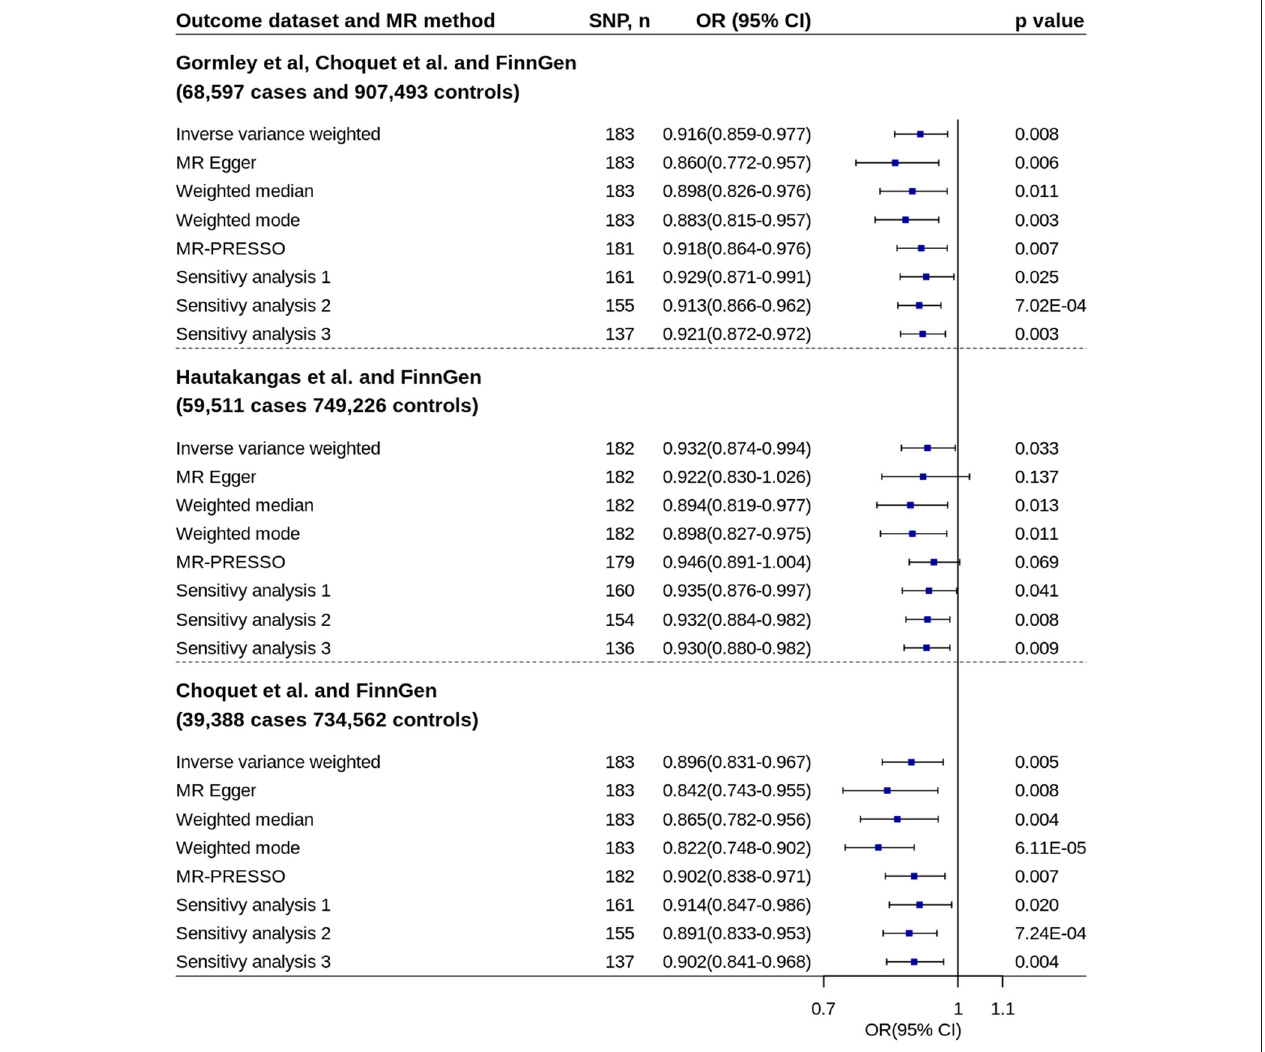
FIGURE 3 | Mendelian randomization analyses of 25OHD on migraine risk using pooled migraine datasets. Sensitivity analysis 1: SNPs associated with potential confounders were excluded. Sensitivity analysis 2: Potential reverse causal SNPs were excluded (Steiger-filtered analysis). Sensitivity analysis 3: All SNPs excluded in sensitivity analysis 1 and sensitivity analysis 2 were excluded. 25OHD, 25-hydroxyvitamin D; CI, confidence interval; MR, Mendelian randomization; MR-PRESSO, MR-Pleiotropy Residual Sum and Outlier; OR, odds ratio; SNP, single nucleotide